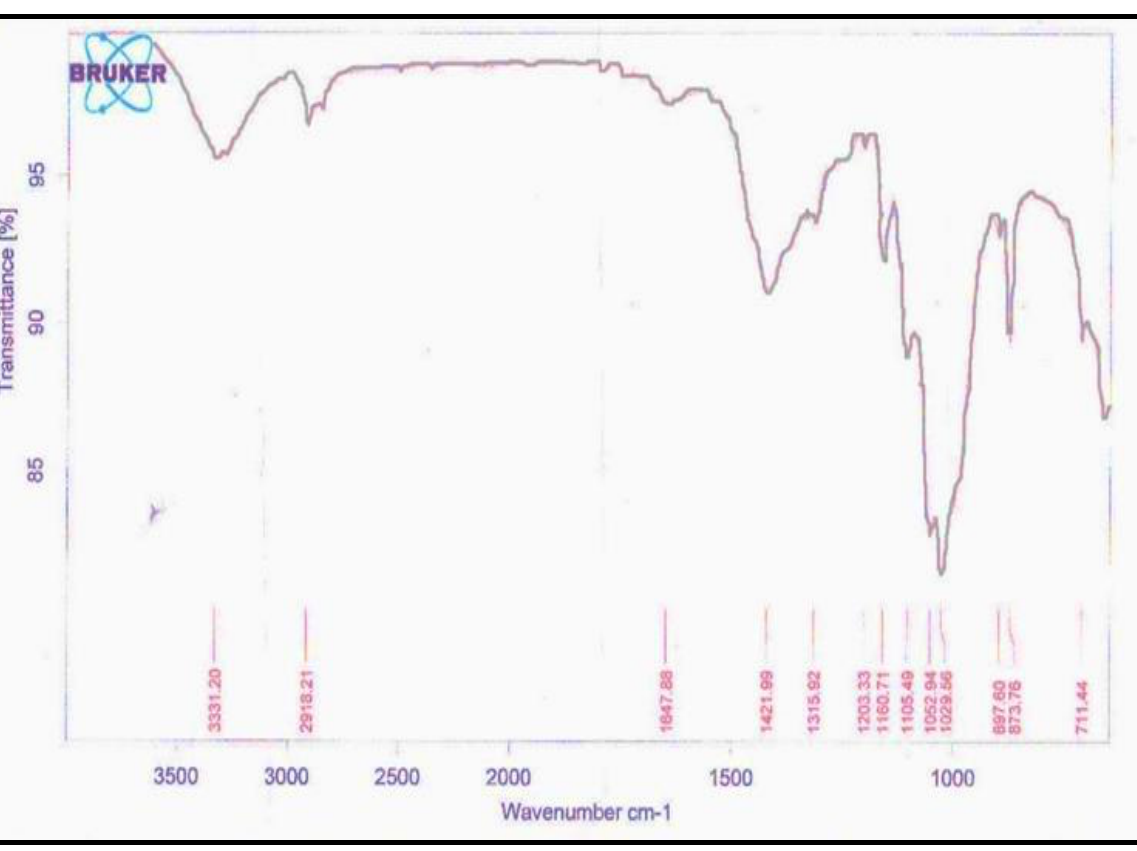
Fig. 6: FTIR spectrum of the industrial waste paper.